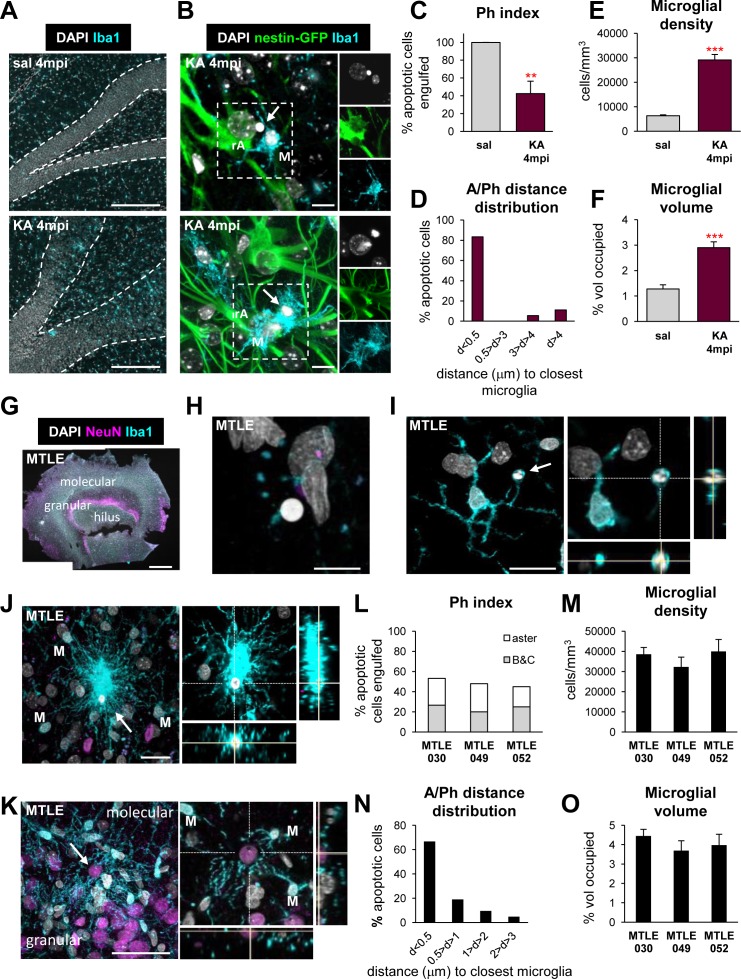
Long-term impairment of microglial phagocytosis in mouse and human MTLE.(A) Representative confocal images of the DG of saline- and KA-injected mice at 4 mpi showing the nuclei (with DAPI, in white) and microglia (Iba1+, in cyan). Note the gross dispersion of the DG in KA injected mice (S4F Fig). The number of apoptotic cells in control and KA-treated mice at 4 mpi is shown in S4G Fig. (B) Upper panel: representative confocal z-stack of an apoptotic cell (pyknotic, with DAPI, in white; arrowhead) located nearby a hypertrophic reactive astrocyte (rA; visualized with nestin-GFP+, in green) and a microglial cell (M; Iba1+, in cyan) at 4 mpi after KA. Lower panel: representative confocal z-stack of an apoptotic cell phagocytosed by microglia at 4 mpi after KA. A representative image of phagocytosis by a reactive astrocyte at 4 mpi after KA is shown in S4H Fig. (C) Ph index in the DG (% of apoptotic cells engulfed). (D) Histogram showing the distribution of the distance (in μm) of apoptotic cells to microglia at 4 mpi after KA (in %). (E) Density of microglial cells (in cells/mm3). (F) Microglial volume (in % of volume of DG occupied). (G) Representative confocal tiled image of a slice of the human hippocampus from an MTLE patient showing cell nuclei (with DAPI, white), neuronal nuclei (NeuN+, magenta), and microglia (Iba1+, cyan). (H) Representative confocal image of a nonphagocytosed apoptotic cell (pyknotic, with DAPI) adjacent to a microglial process (Iba1+) in the hippocampus of an MTLE patient. (I) Representative confocal image of phagocytosis by a ball-and-chain mechanism in the hippocampus from an individual with MTLE. The apoptotic cell (pyknotic, with DAPI in white; arrow) was engulfed by a terminal branch of a nearby microglia (Iba1+, cyan). The right panel shows an orthogonal projection of the same cell, where the 3-D engulfment is evident. (J) Representative confocal z-stack of phagocytosis by an aster mechanism in the hippocampus from an individual with MTLE. The apoptotic cell (pyknotic, with DAPI in white; arrow) was engulfed by a mesh of processes from many surrounding microglia (Iba1+, cyan; M). The right panel shows an orthogonal projection of the same cell. (K) Representative confocal z-stack of a granule neuron in the DG (NeuN+, magenta; arrow) targeted by the processes of several surrounding microglia (Iba1+). Nuclei are shown in white (DAPI). The right panel shows an orthogonal projection of the same neuron directly targeted the processes of up to three microglia (M). Another example is shown in S8A Fig and further data in S1 Table. (L) Ph index in the human DG (% of apoptotic cells engulfed). (M) Density of microglial cells (in cells/mm3) in the DG of three hippocampal samples from human MTLE patients. (N) Histogram showing the distribution of the distance of apoptotic cells (in %) to Iba1+ microglial processes in the DG of MTLE patients (n = 21 cells from 3 patients). (O) Microglial volume (in % of volume of DG occupied) in the three hippocampal samples from individuals with MTLE. Bars represent mean ± SEM (C, E, F), the individual values of all the pooled cells for each patient (L), the average values for measures in different z-stacks for each patient (M, O), or the sum of cells in each distance slot (D, N). ** represents p < 0.01 by Student´s t test (C, E, F). Scale bars = 50μm (A, K), 10 μm (B, H, I), 1 mm (G), 20 μm (J). z = 25 μm (A), 6.6 μm (B, upper panel), 12.7 μm (B, lower panel), 2.8 μm (H), 2.6 μm (I), 5.2 μm (J), 12 μm (K). Underlying data is shown in S1 Data.